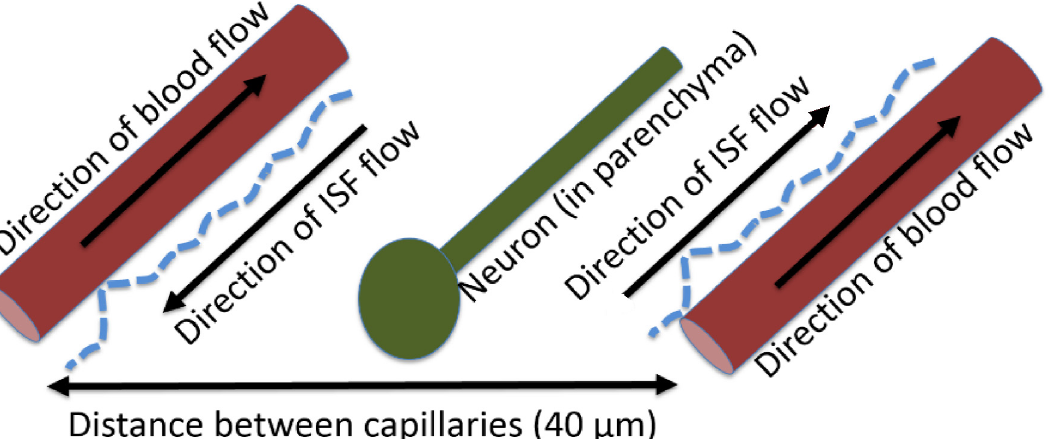
Fig 2. Flow of brain interstitial fluid in response to pulsations of cerebral arteries and arterioles. Interstitial fluid is generated at the brain endothelium by an unclear process [30] and surrounds neurons, microglia astrocytes and other cells located within the brain parenchyma, bringing nutrition to the cells and removing wastes. Although its chemical composition is similar to cerebrospinal fluid (CSF), the two fluids serve separate purposes. CSF gives the brain buoyancy and buffers against forces applied to the head; CSF is generated by ependymal cells within the choroid plexus [30]. Brain ISF transports waste from the brain parenchyma via a combination of convection and diffusion towards the perivascular space. At the perivascular space, molecules such as A β , are either transported by receptors at the blood-brain barrier, or are transported along the glymphatic pathway. A small percentage of molecules transported in the perivascular space are transported into the cerebrospinal fluid at the arachnoid granulations and are cleared from the brain via CSF drainage pathways. The majority (~60%) of A β is transported along the glymphatic system to the cervical lymph nodes